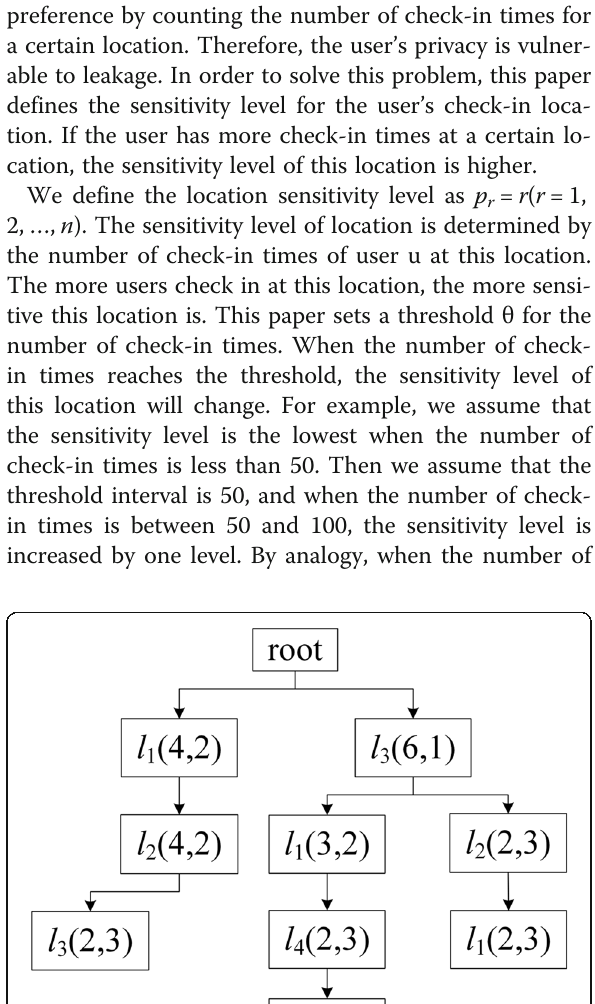
Sequence Track path